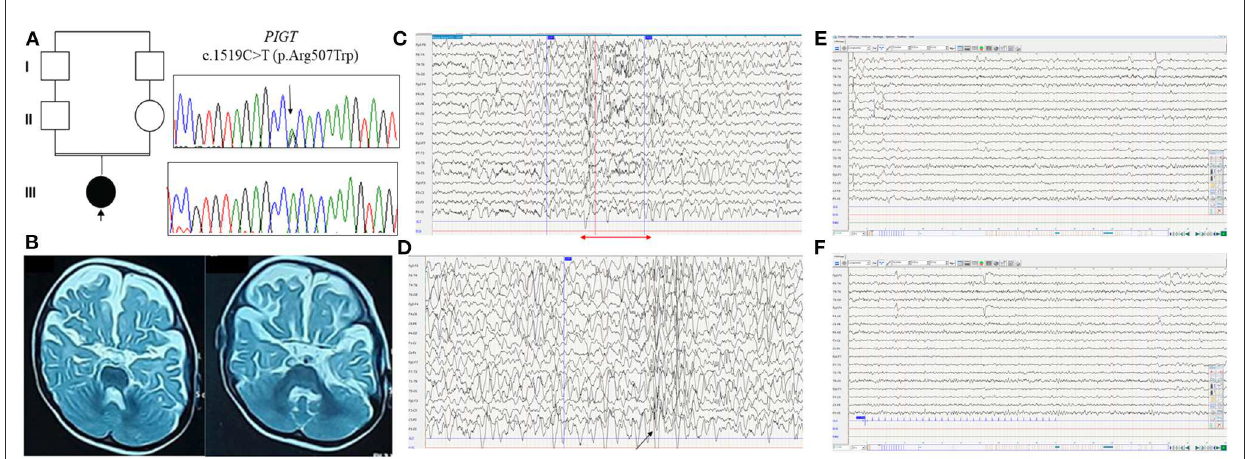
FIGURE1 Clinical and molecular findings in the Libyan family with PIGT variant c.1519C > T; p.Arg507Trp. (A) Pedigree of the reported family with electropherograms of the identified homozygous PIGT variant (III.1) compared with heterozygous carrier sequences (II.1 and II.2). (B) Brain MRI T2-weighted axial images reveal severe atrophy of the cerebral hemispheres with slight cerebellar hypoplasia. (C) EEG recording, obtained when the patient was 2 years old, with the following parameters: 20 electrodes, 7 µ v/mm, 0.03s, 15, 50Hz. The EEG shows slow spike-wave discharge followed by diffuse fast rhythms (red arrow). (D) Sleep EEG shows moderately organized EEG with the presence of rare spindles and diffuse spike-wave discharges (black arrow). (E, F) EEG showing normal background rhythm without